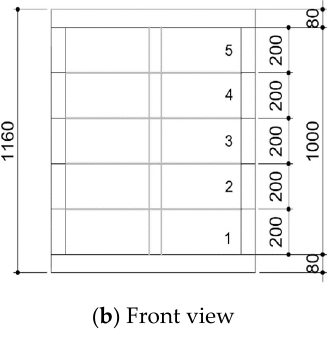
Figure 7. Drawing of the unit structure (mm).